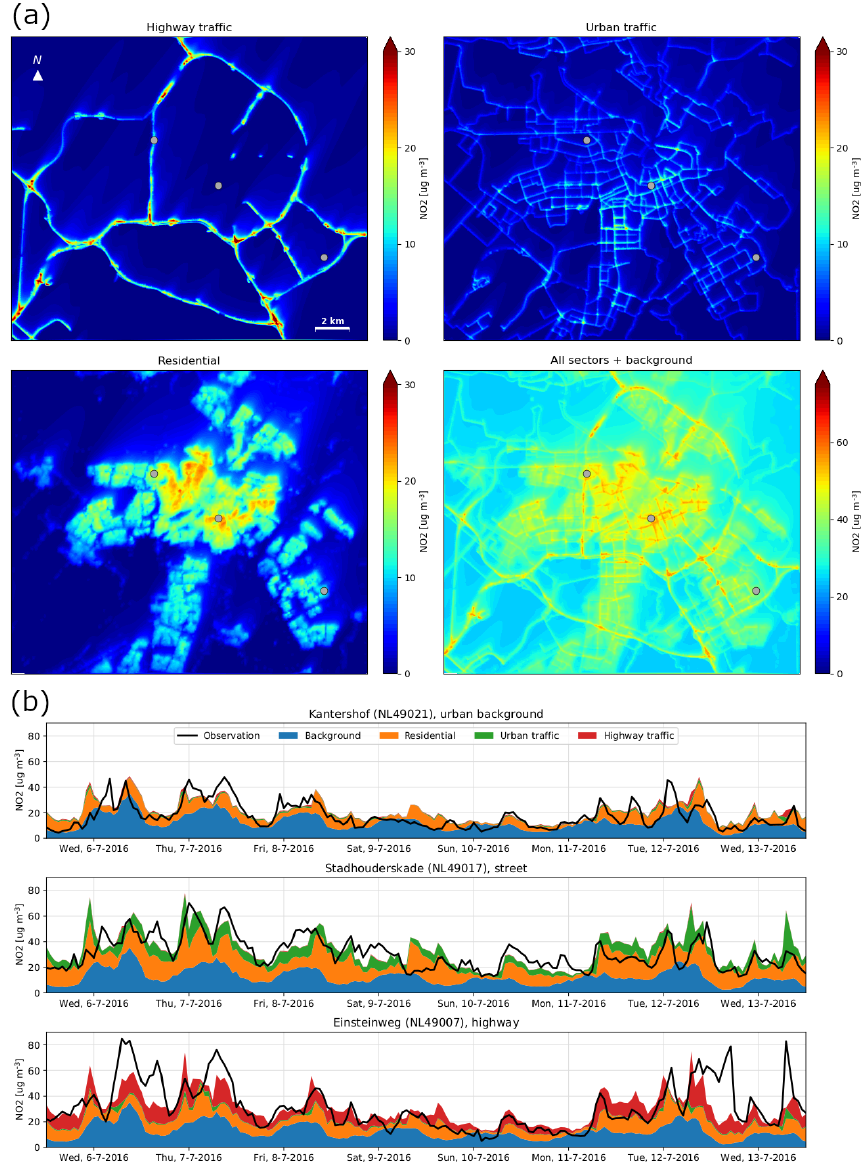
Figure 4. (a) Dispersion maps of NO 2 concentrations for each emission sector on 8 July 2016 at 09:00. The lower-right panel shows the linear combination which best fits the time series at the calibration sites. Wind is blowing from the southwest at 16kmh − 1 . The grey dots indicate an urban-background location, a street location, and a highway location. (b) Comparison of observed and simulated NO 2 time series (date format of day-month-year) for the urban-background location, the street location, and the highway location. The colours indicate the simulated contribution of the three source sectors and the